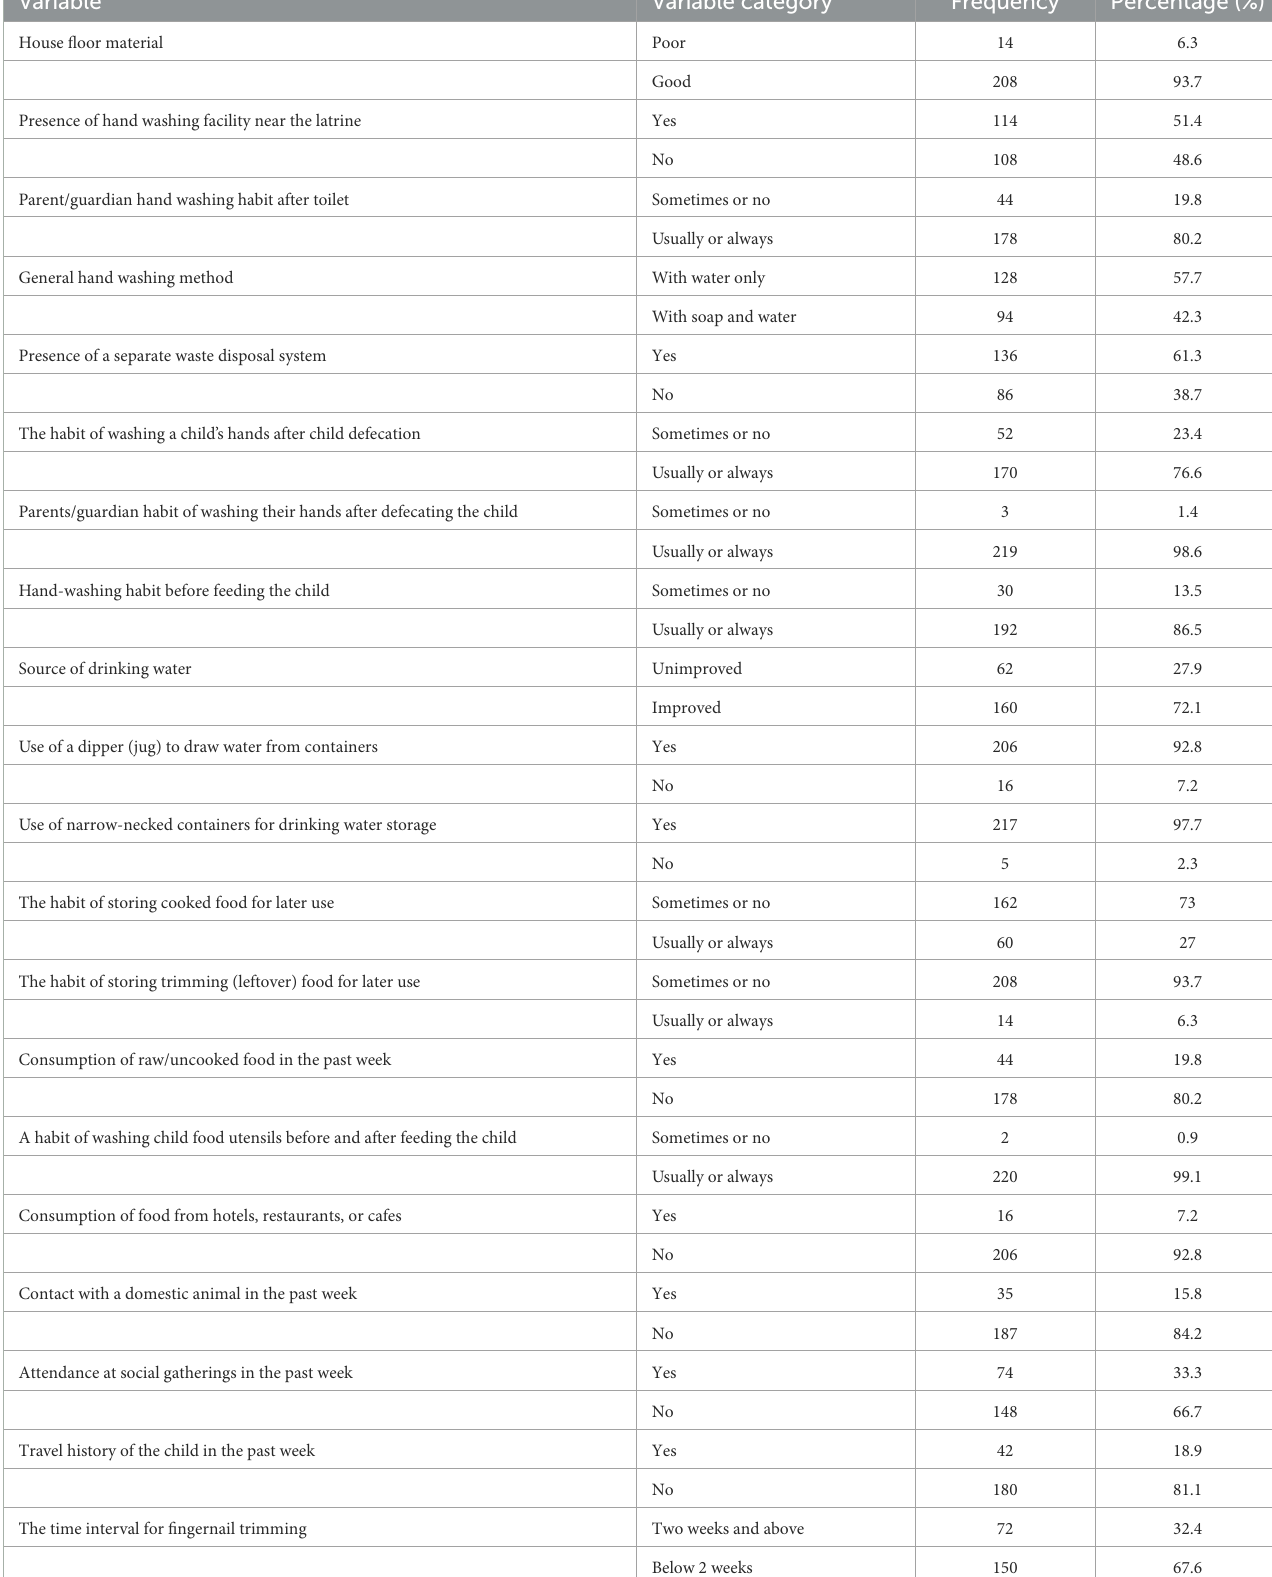
TABLE 3 Hygiene-related and behavioral characteristics of the study participants in public health facilities in Debre Markos town,